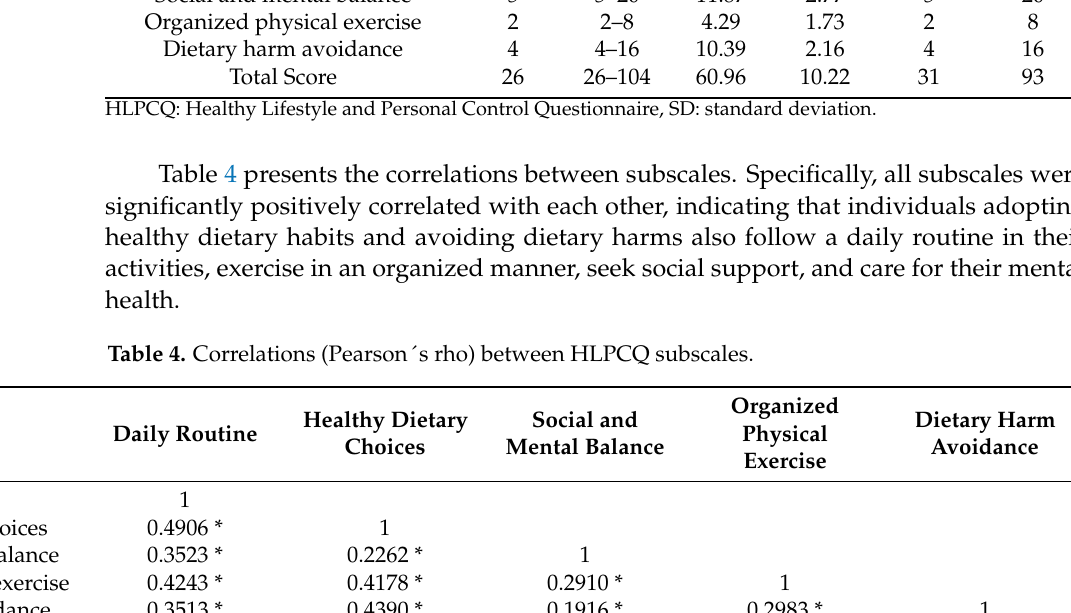
Table 3. Descriptive characteristics of the five subscales and the total score of HLPCQ. Items Range Mean SD Min. Max. Daily routine